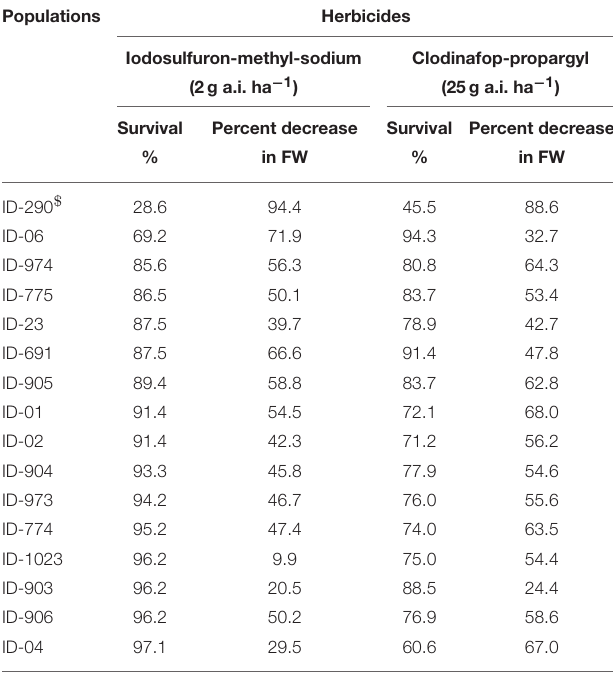
TABLE 1 | Screening of L. multiflorum population using an ALS (iodosulfuron-methyl-sodium) and an ACCase (clodinafop-propargyl) inhibitor herbicide.